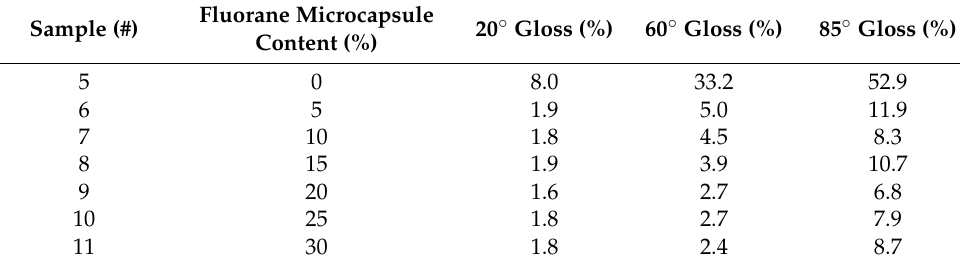
Table 5. Effect of fluorane microcapsule concentration on the gloss of topcoats.